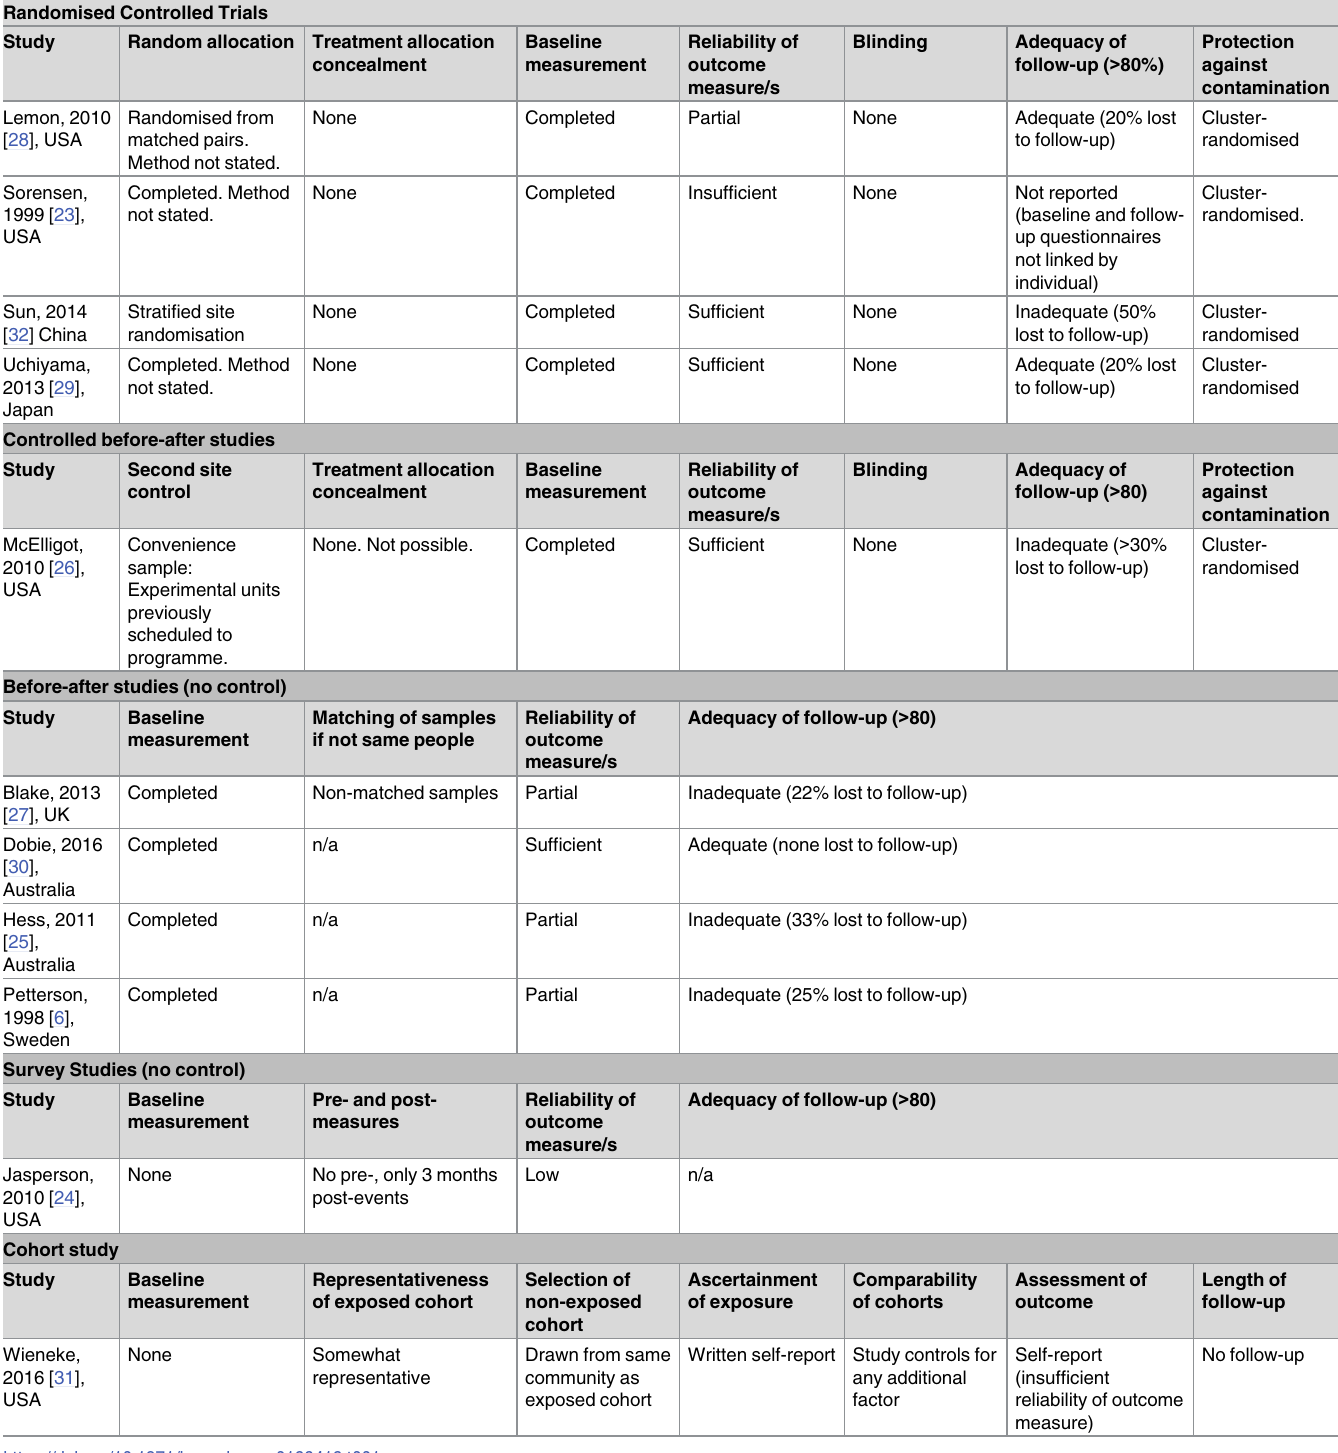
Table 1. Summaryof design and quality of studies in the